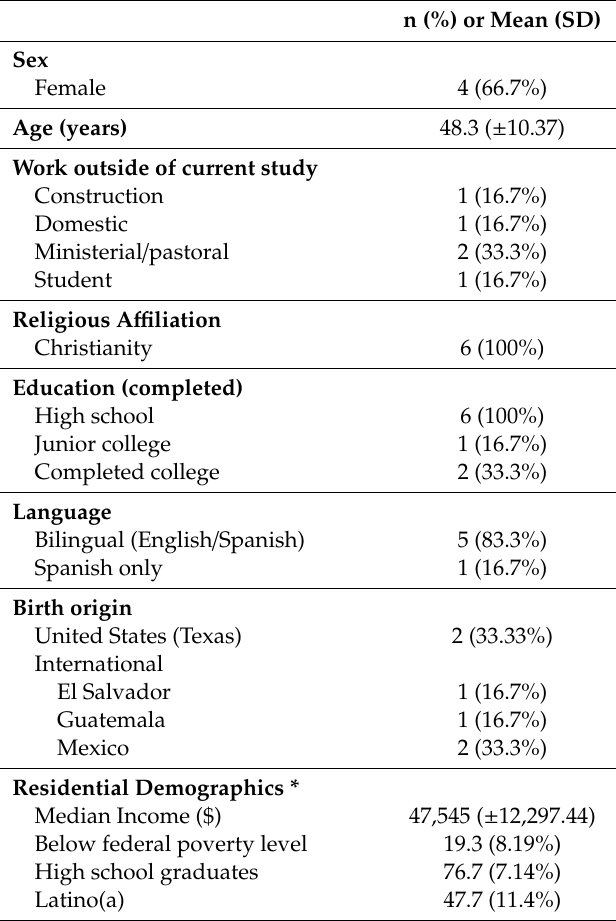
Table 2. Baseline Community Health Worker Characteristics (n =